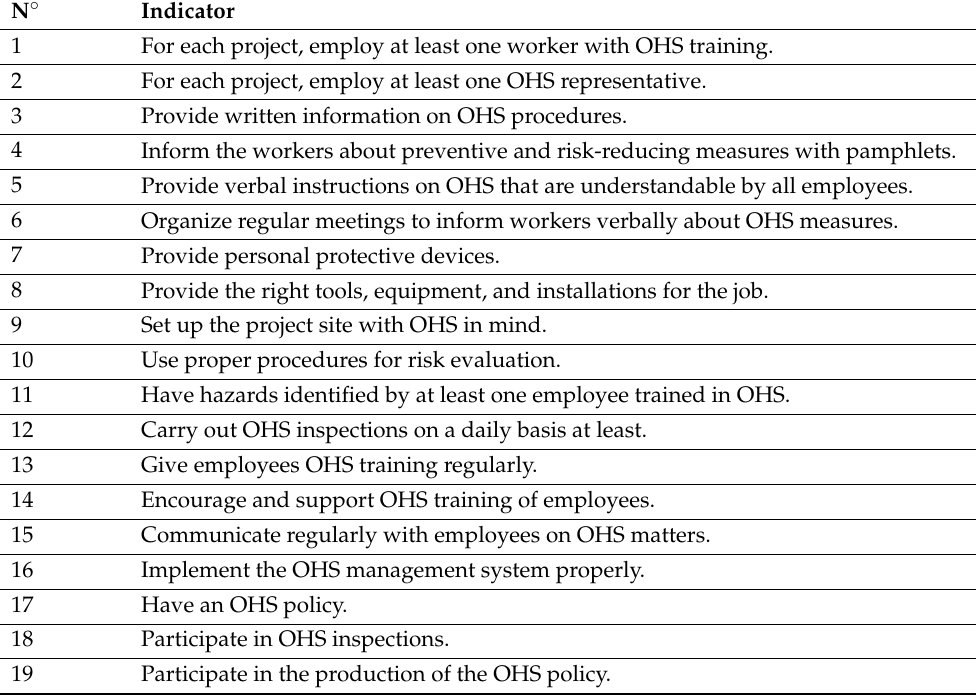
Table 7. Construction project indicators proposed by